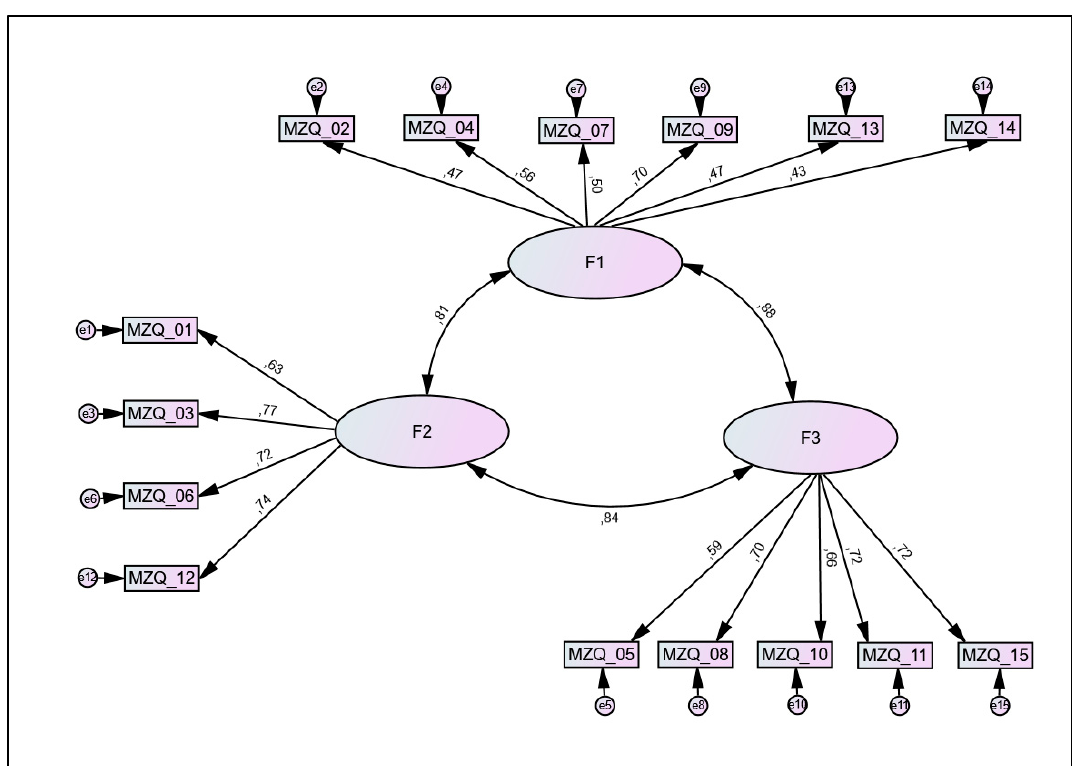
Figure 2. Newly introduced 3-factor solution for the Mentalization Questionnaire (MZQ). Large circles represent proposed factors, rectangles represent items (with corresponding item number), and small circles represent error terms (e). Numbers next to arrows in the model represent standardized estimates. F1 = factor 1 (‘mental states in oneself regarding others—cognition and communication’; F2 = factor 2 (‘mental states regarding oneself—affect-regulation’); F3 = factor 3 (‘mental states regarding oneself—affect-perception and -differentiation’).